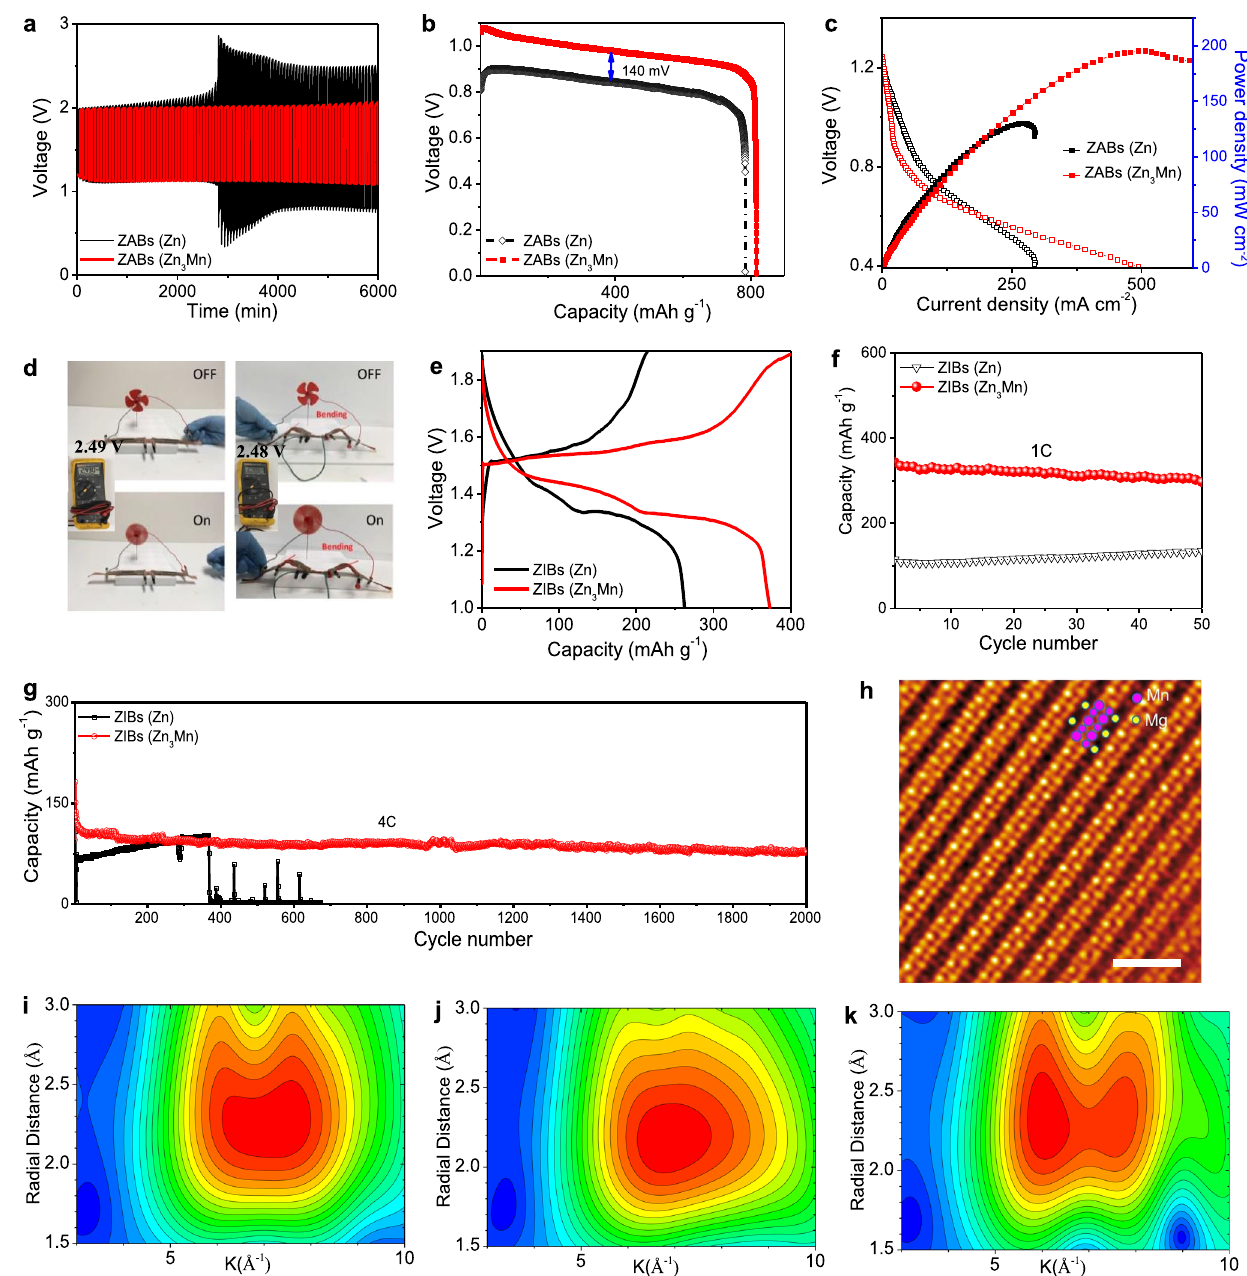
Fig. 4 Electrochemical performance and characterizations of aqueous Zn batteries. a Cycling performance of ZABs (Zn 3 Mn) and ZABs (Zn). b Discharging plateaus of ZABs (Zn 3 Mn) and ZABs (Zn) at a current density of 30 mA cm − 2 . c Discharging and power density plots of ZABs (Zn 3 Mn) and ZABs (Zn). d Photograph of an electric fan powered by two fl exible ZABs (Zn 3 Mn). e Typical charge/discharge pro fi les of ZIBs (Zn 3 Mn) at 0.5 C (electrolyte: 2 M ZnSO 4 and 0.1 M MnSO 4 in seawater). Cycling performance of ZIBs (Zn 3 Mn) at f 1C and g 4C, respectively. h High-resolution HAADF- STEM image of a fully discharged MnO 2 cathode for ZIBs (Zn 3 Mn) using Mg 2 + -containing aqueous electrolyte. The yellow and pink dots represent Mg and Mn atoms, respectively. Scale bar: 1 nm. Wavelet transform of Mn K-edge EXAFS for i pristine Zn-Mn anode, j fully discharged Zn-Mn anode, and k fully charged Zn-Mn